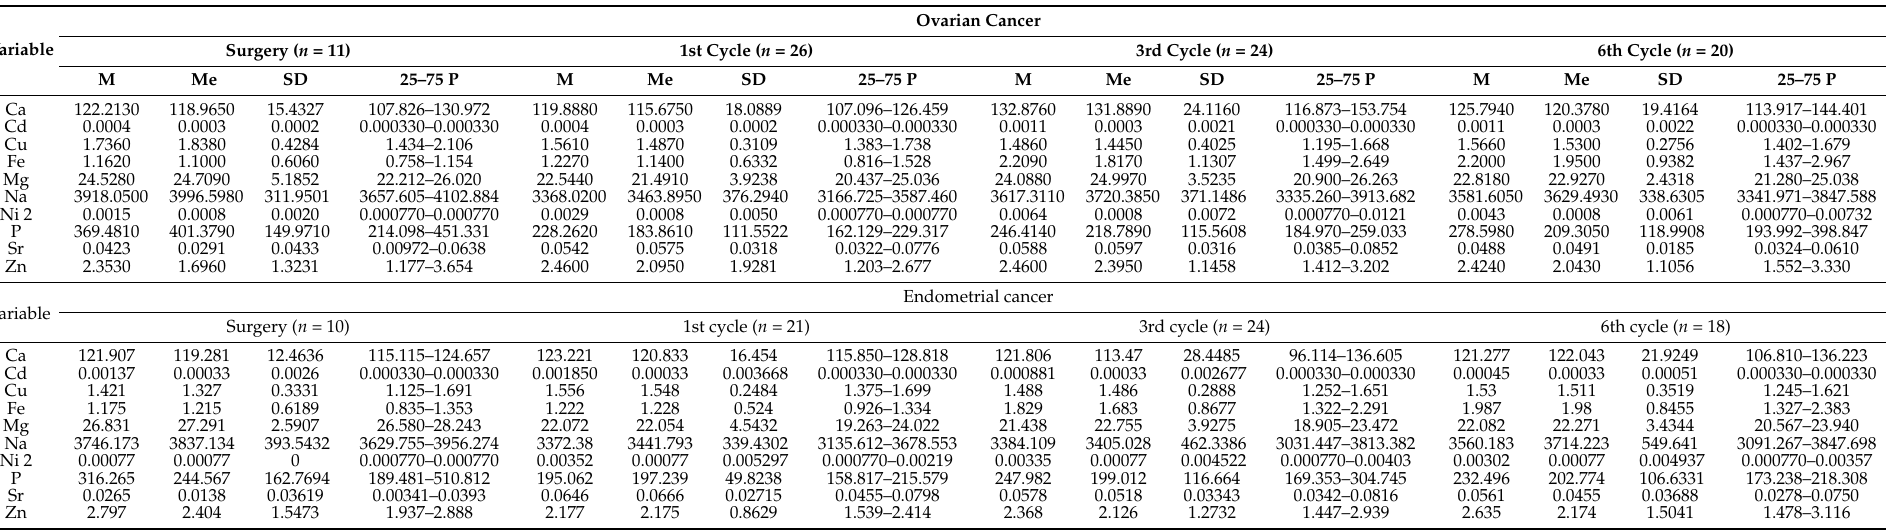
Table 2. Descriptive statistics of the tested elements by the type of cancer and the stage of